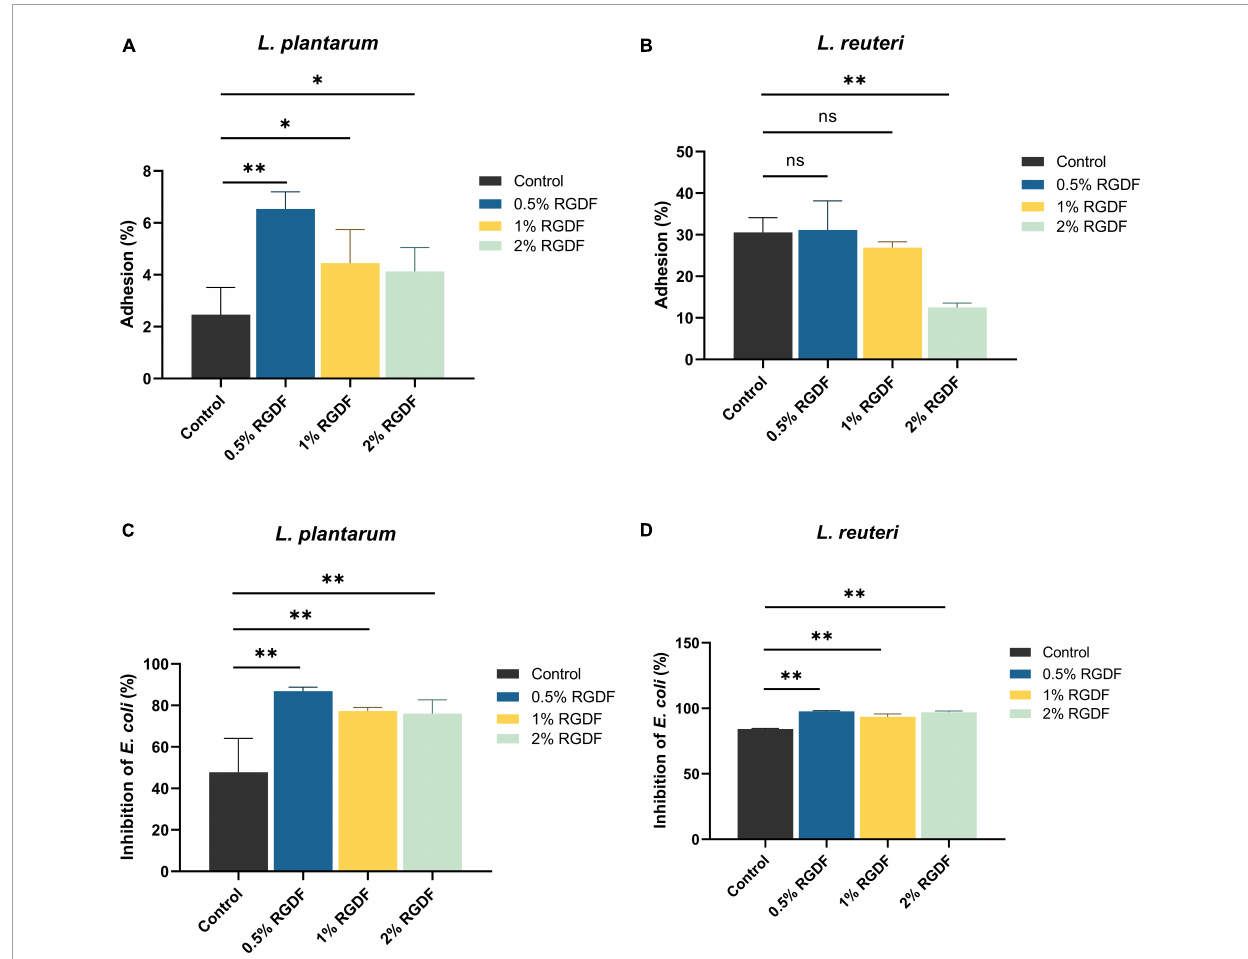
FIGURE2 Gut epithelial adhesion (A,B) and inhibition of E. coli attachment (C,D) of L. plantarum and L. reuteri . Differences were indicated at a significance level of 95% ( ∗ ) and 99% ( ∗∗ ), as determined by one-way ANOVA with Dunnett’s post-hoc analysis.